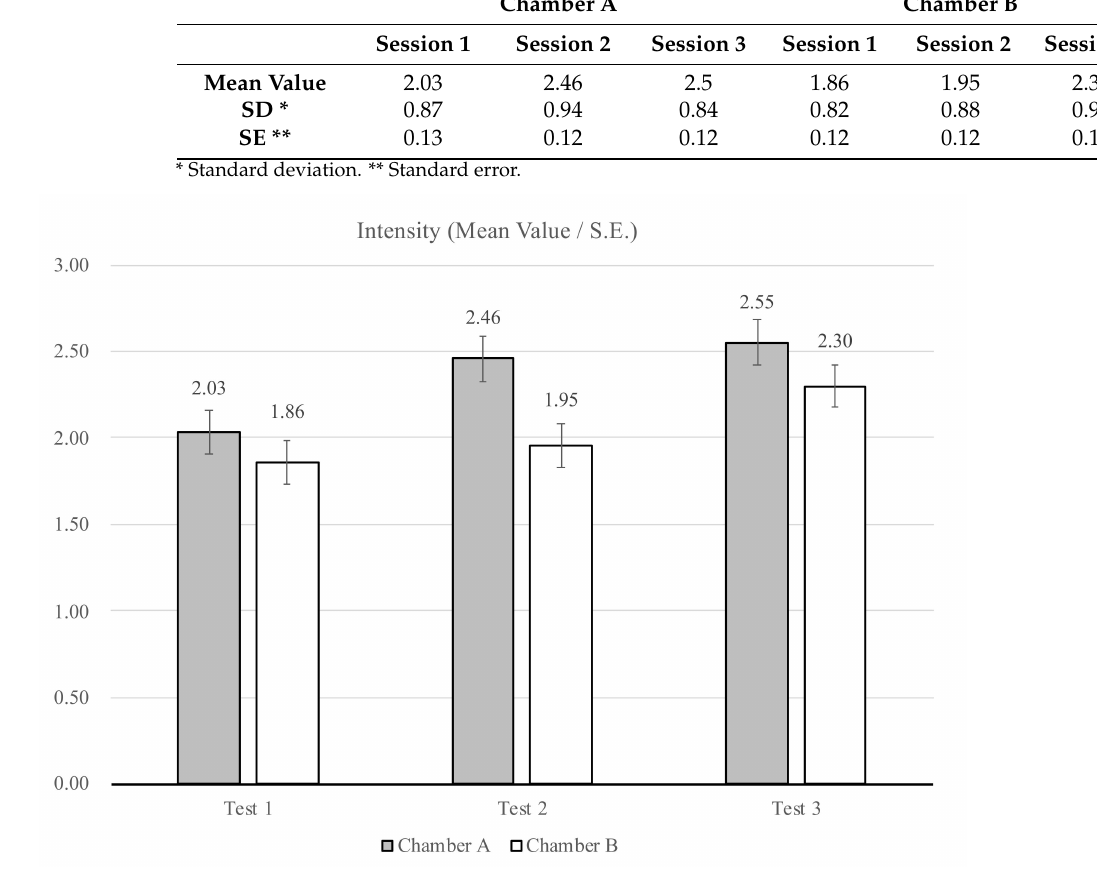
Figure 8. Intensity assessment for the two chambers at the three sessions: mean values and standard errors (SEs) (Session 1: n = 44; Session 2: n = 57; Session 3: n =